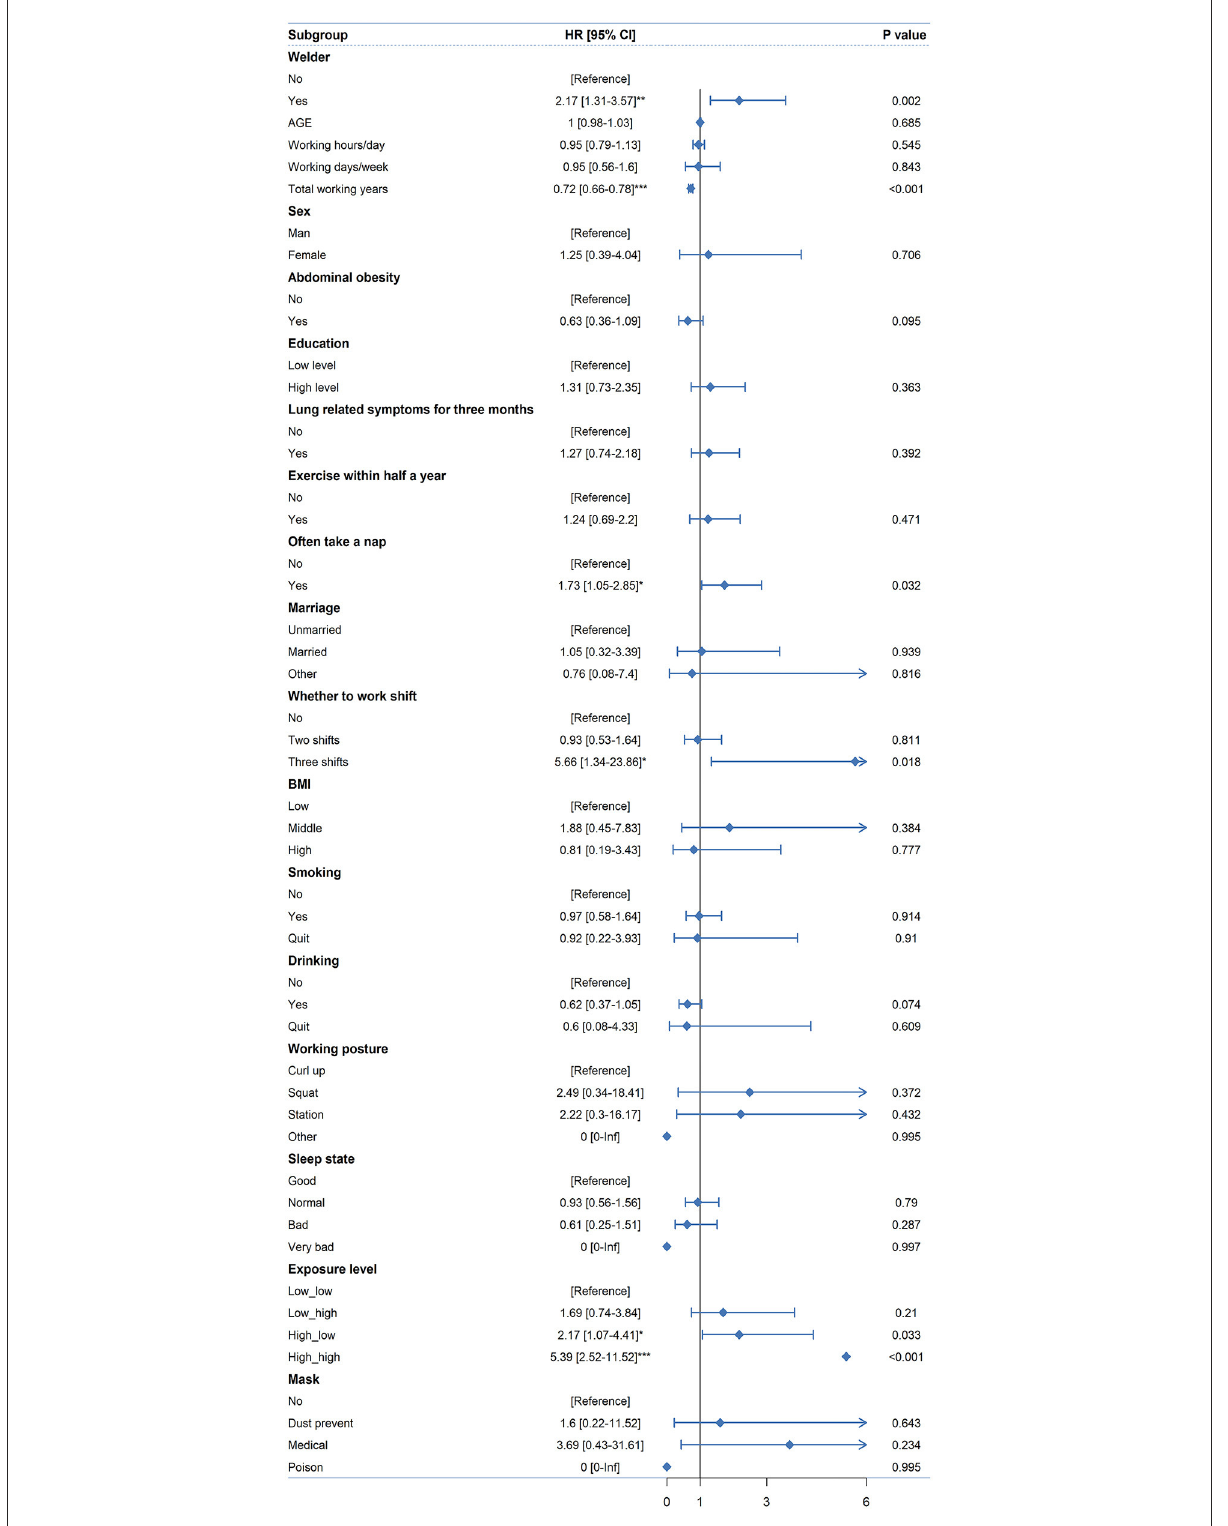
FIGURE2 Independent risk factors for lung-related diseases. (* p < 0.05; ** p < 0.01; *** p <